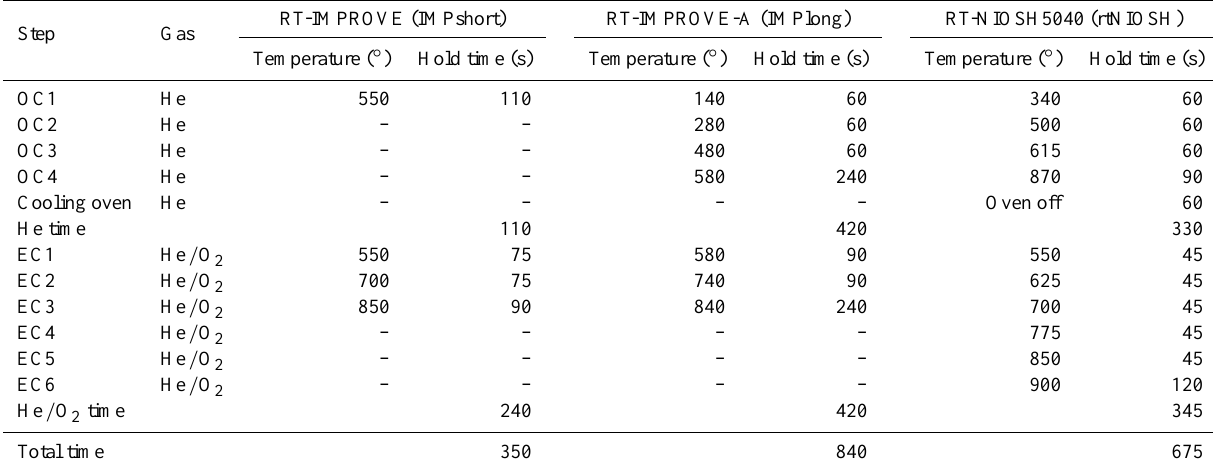
Table 1. Temperature protocols used for the Sunset semi-continuous OC / EC